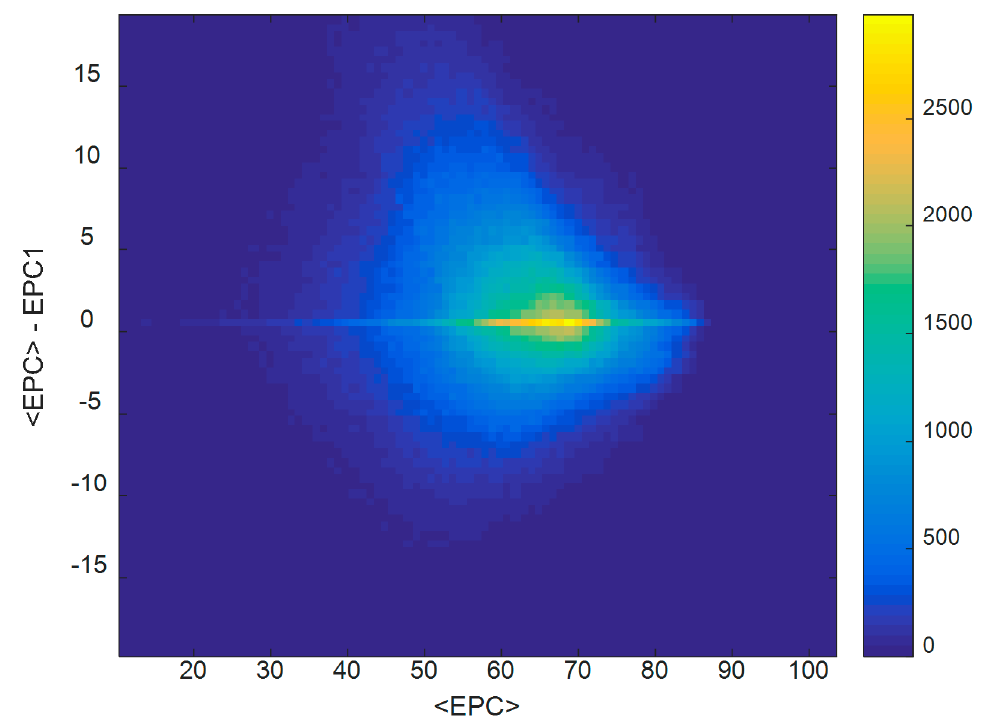
Figure 5. < EPC > -EPC1 plotted against < EPC > . Illustrating the divergence of per-house measurements from their Figure 5. <EPC>-EPC1 plotted against <EPC>. Illustrating the divergence of per-house measurements from their mean.